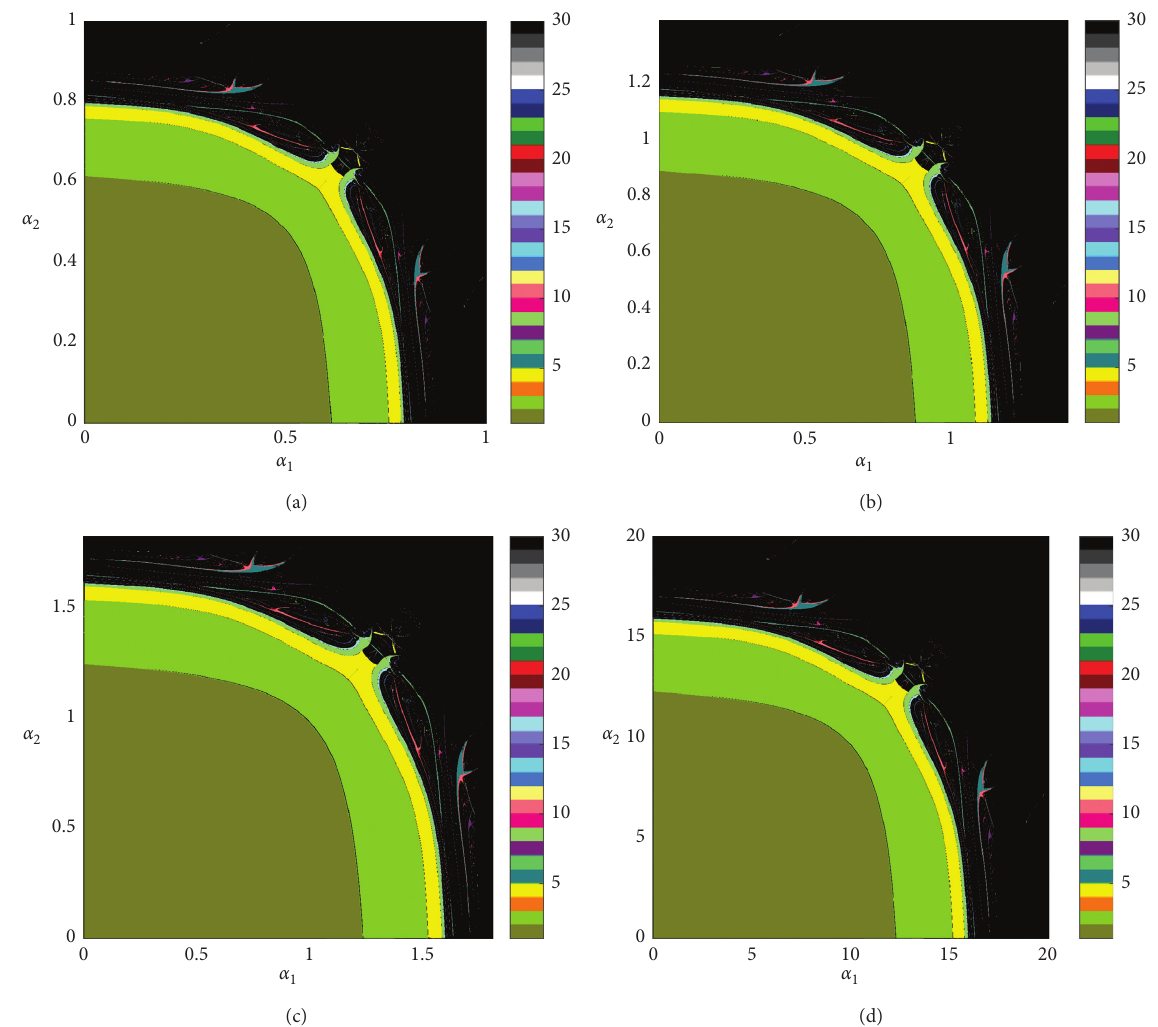
Figure 9: The two-dimensional bifurcation of system (33) with respect to a pair of parameters ( α � μ � 0 . 5; (d) μ μ 1 2